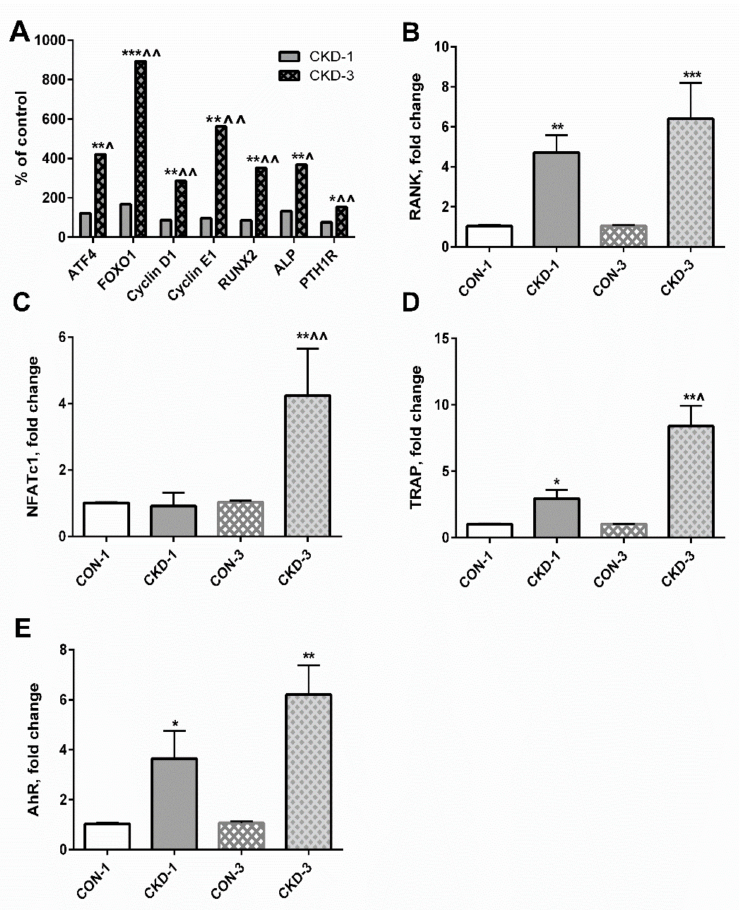
Figure 5. The expression of genes involved in osteogenesis ( A – D ), and the expression of aryl hydrocarbon receptor (AhR) gene ( E ) in bone of young rats with chronic kidney disease (CKD). * p < 0.05, ** p < 0.01, *** p < 0.001 CKD versus appropriate controls; ˆ p < 0.05, ˆˆ p < 0.01 CKD- 3 versus CKD-1. Abbreviations: ATF4 = activating transcription factor 4; CON-1 = sham op- erated rats, 1 month after surgical intervention; CON–3 = sham operated rats, 3 month after surgical intervention; CKD-1 = subtotal nephrectomized rats, 1 month after surgical intervention; CKD-3 = subtotal nephrectomized rats, 3 month after surgical intervention; CKD = chronic kidney disease; FOXO1 = Forkhead box transcription factor 1; RUNX2 = Runt-related transcription factor 2; ALP = alkaline phosphatase; PTH1R = parathyroid hormone 1 receptor; RANK = receptor acti- vator of nuclear factor kappaB; NFATc = nuclear factor of activated T cell cytoplasmic 1; TRAP = tartrate—resistant acid